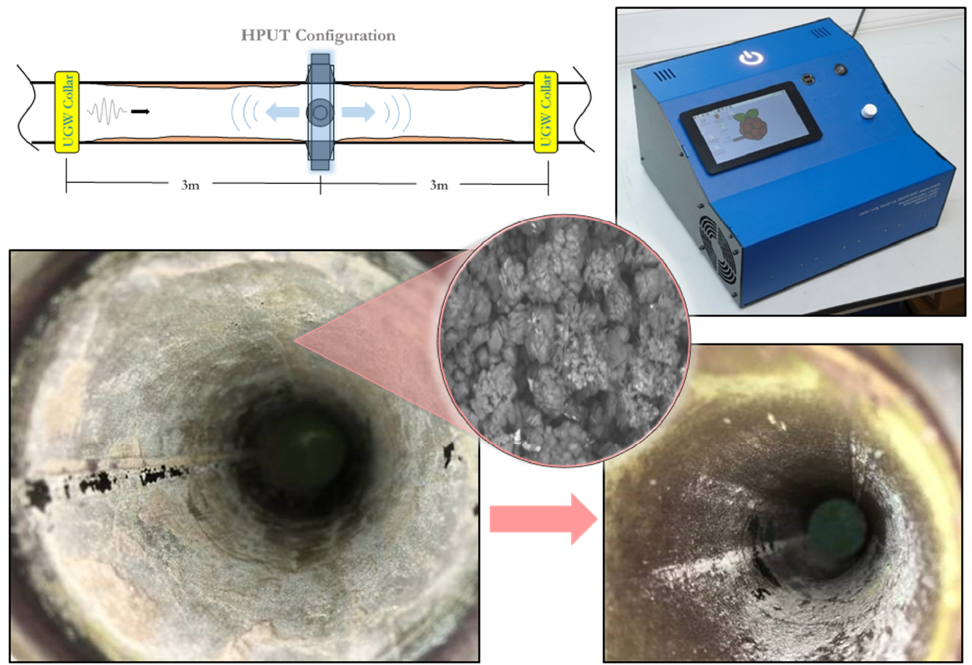
Figure 21. Integrated system schematic, displaying cleaning results after a cycle of fouling removal.